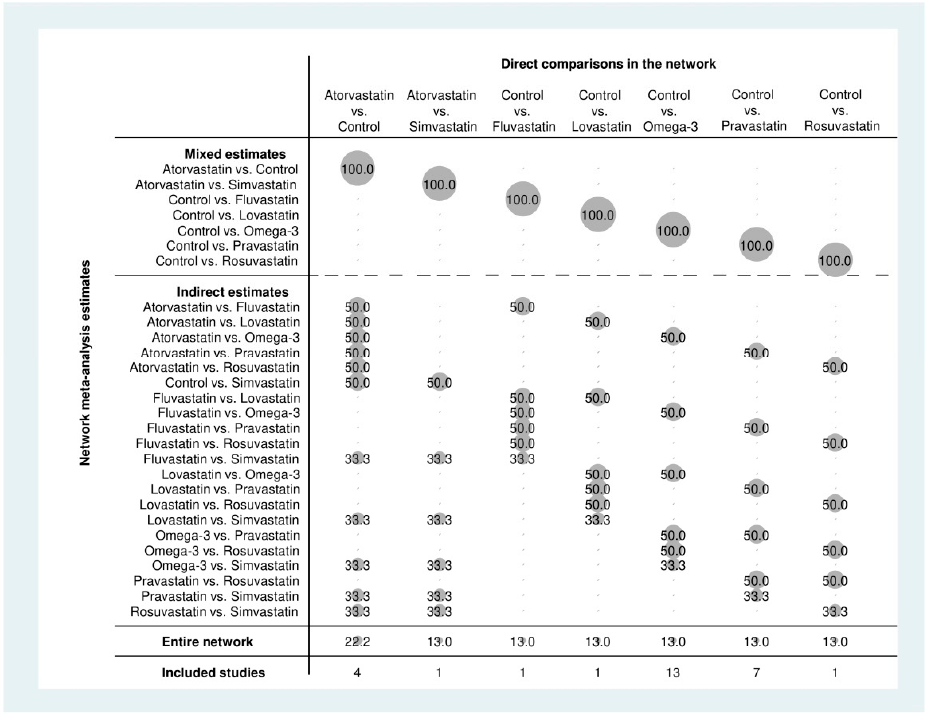
Figure A4. Contribution plot for the total cardiovascular disease network. The size of the square is weighted as the percentage (as number) of the contribution of the direct estimate (horizontal axis) to the network estimate (vertical axis).